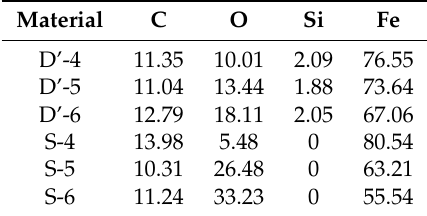
Table 7. Energy-dispersive X-ray spectroscopy (EDS) results of the worn surface of the ductile iron and carbon steel wheels under a normal load of 50 N at di ff erent sliding